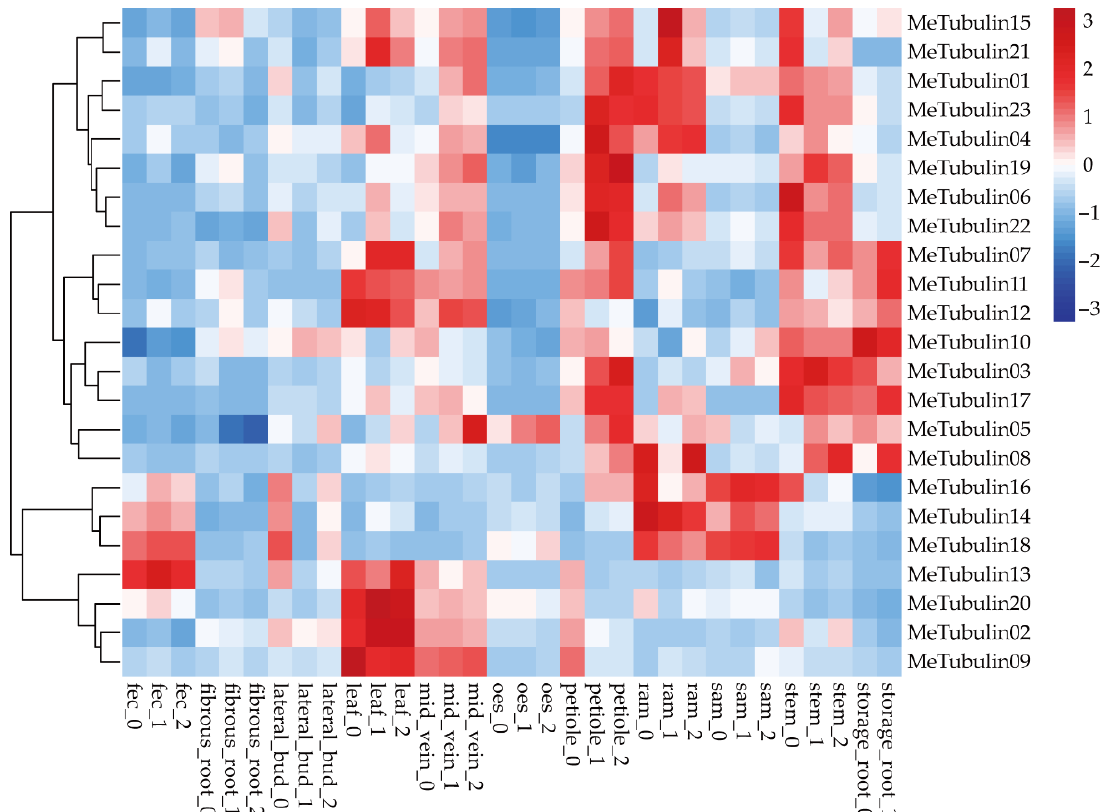
Figure 6. Expression profiles of the cassava tubulin genes. Hierarchical clustering of expression profiles of cassava tubulin genes in various tissue